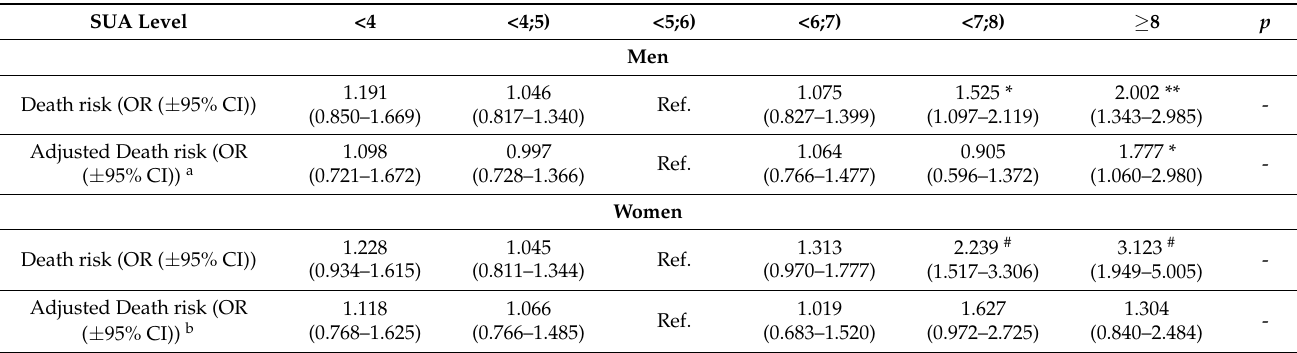
Table 4. The multivariable logistic regression analysis of the death risk in men ( N = 2038; 51.9%) and women ( N = 1888; 48.1%) SUA level